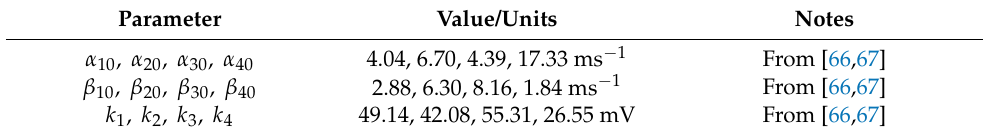
Table 9. Reaction rates for kinetic schemes for VGCC.